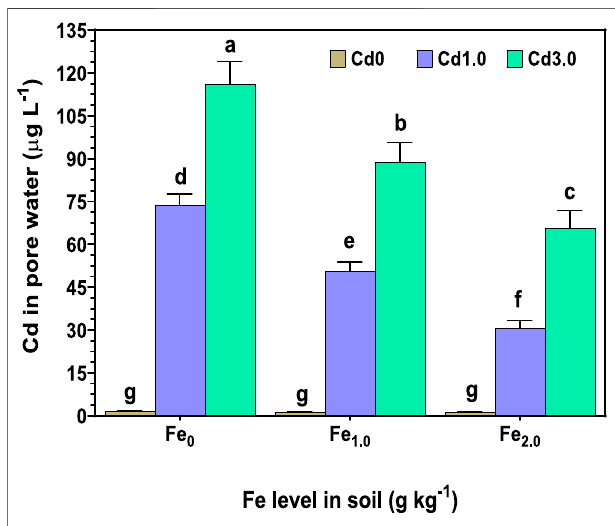
FIGURE 3 | Concentration of Cd in pore water at different levels of supplied Fe and Cd in soil. Levels not connected by the same letter are signi fi cantly different ( p < 0.001). Data are mean ± SE (standard